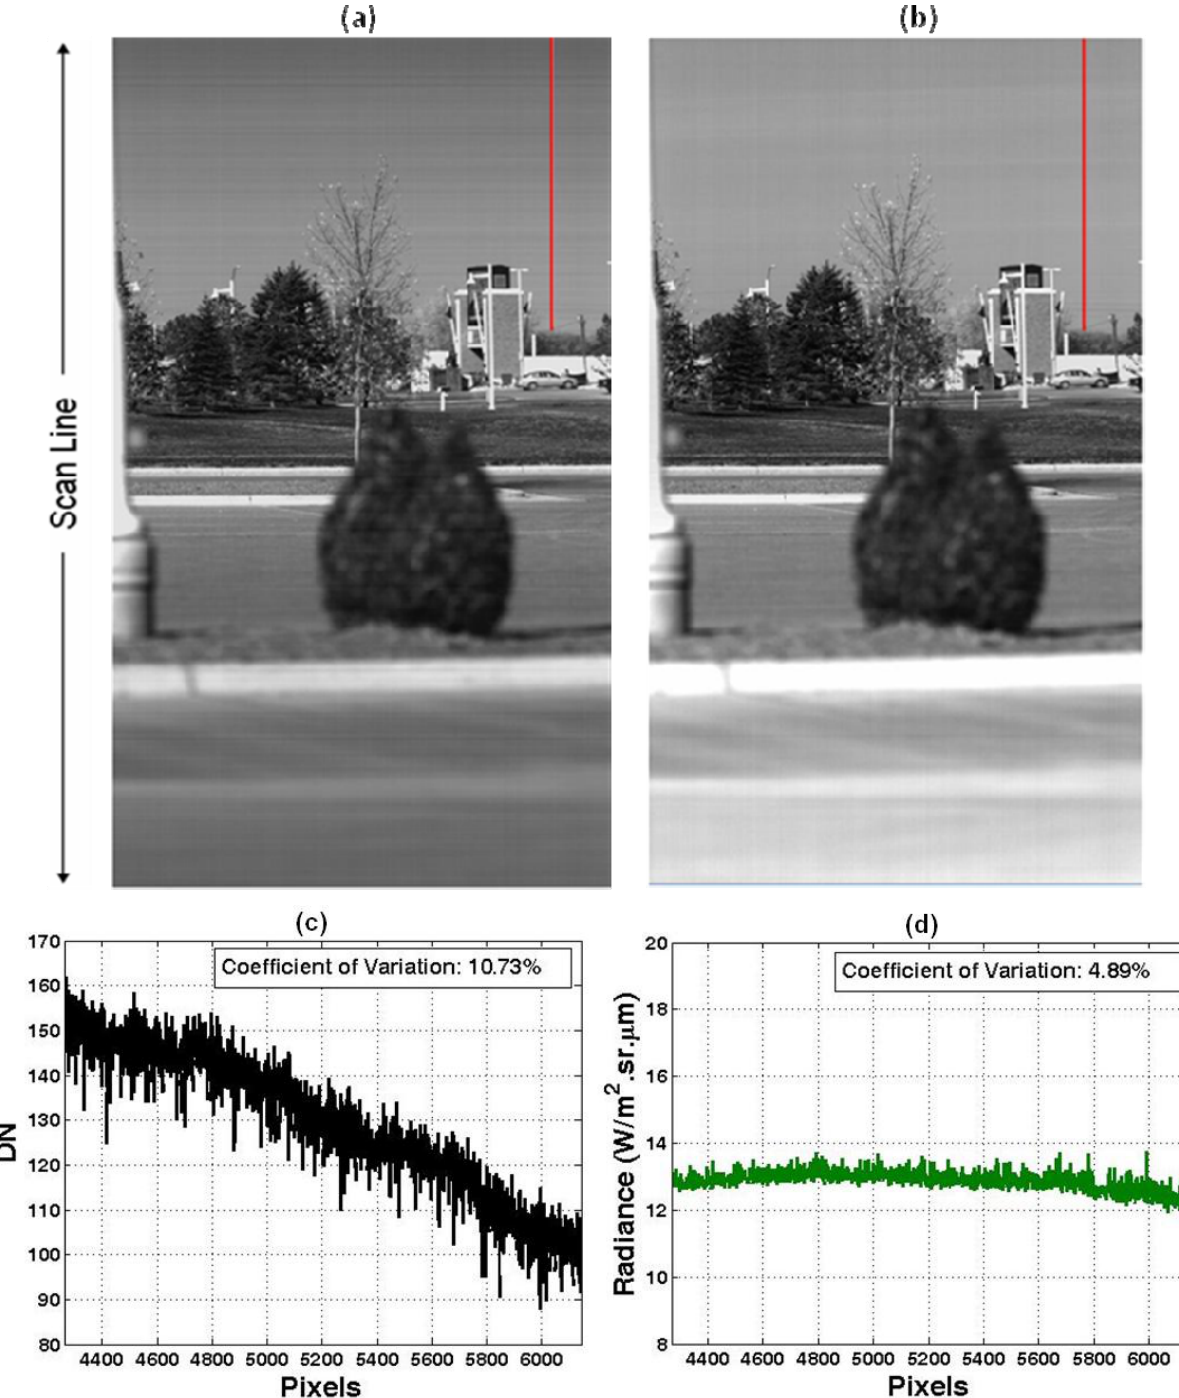
Figure 8. Results of calibrated AgCam image (RED, 200  s). Data was acquired